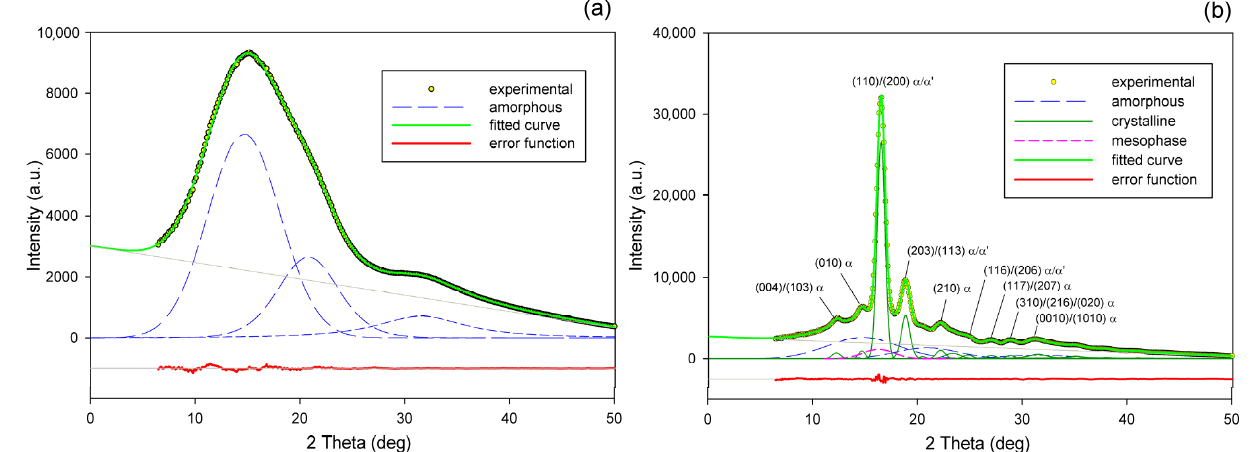
Figure 2. Examples of fitting the amorphous halos and mesomorphic and crystalline peaks to the scattering curve of A ( a ) and CC samples ( b ).